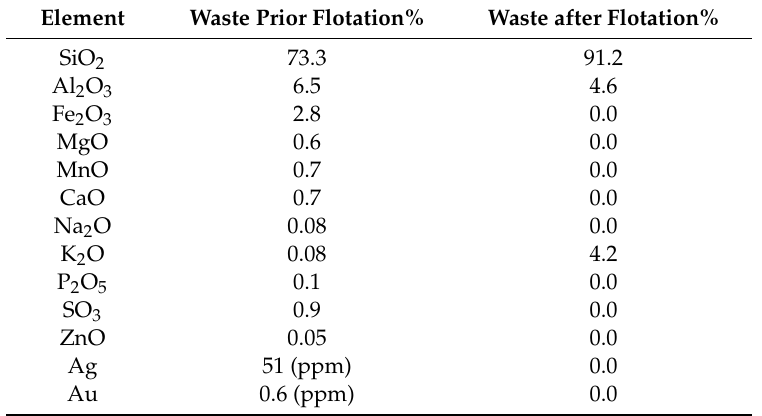
Table 1. X-ray fluorescence (XRF) chemical analysis of material used for the flotation of silica. Element Waste Prior